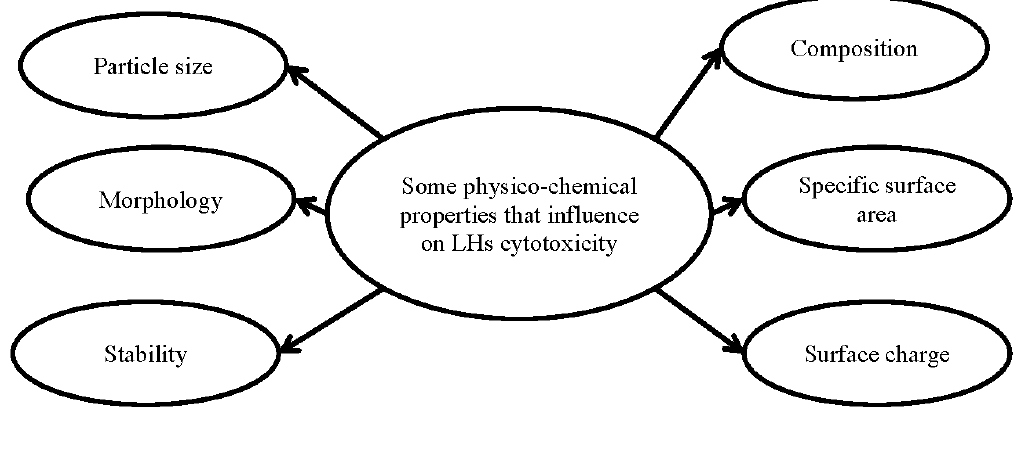
Figure 7. Physicochemical properties of layered hydroxides that affect their